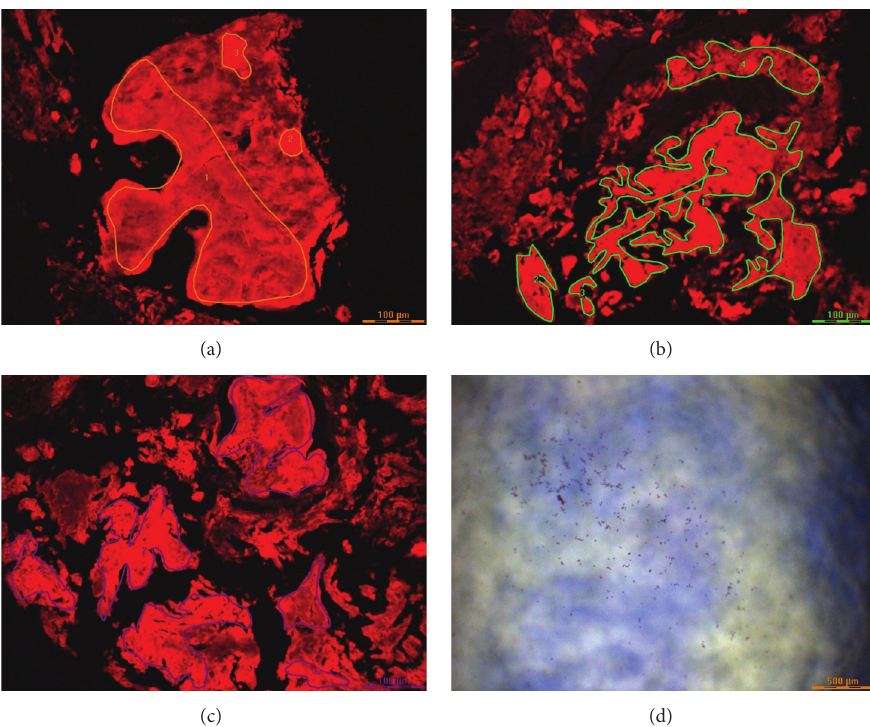
Figure 3: Congo red-positive sections viewed under ultraviolet light in the microdissection microscope. The amyloid fluoresces red. The drawn lines (yellow in (a), green in (b), and blue in (c)) delineate areas circumscribing the amyloid deposits that were cut out of the tissue sections for processing for mass spectrometry. The three dissections in (a)–(c) correspond to the three patient sample columns in the Scaffold illustration in Table 1. Each sample was processed in triplicate. (d) shows the amyloid fragments that have been cut out of the tissue and are now in the reaction cup for further processing (i.e., reduction of disulfide bonds, trypsin digestion, etc.) before mass